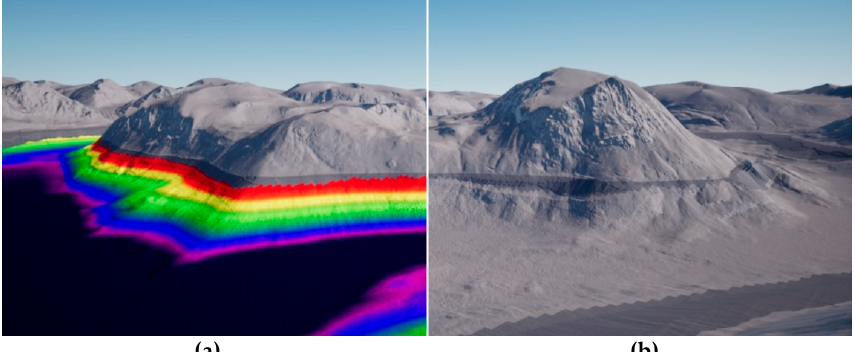
Figure 12. Landscape scenery in UE4 without the water surface depicting the grey coloration for the terrestrial terrain. The bathymetry is colored in rainbow colors relative to the depth ( a ) or light grey for the MBES bathymetry and dark grey for the transition zone ( b ).